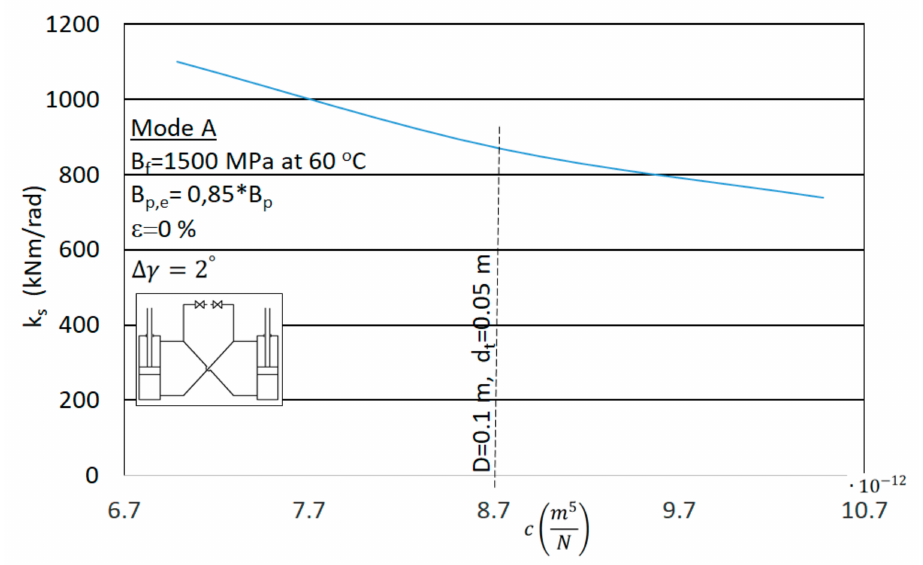
Figure 18. Influence of the capacitance of the hydraulic steering system on its equivalent torsional stiffness k